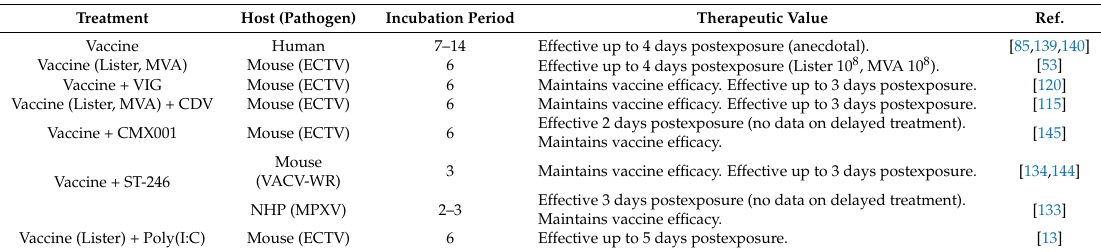
Table 1. Efficacy of postexposure combination